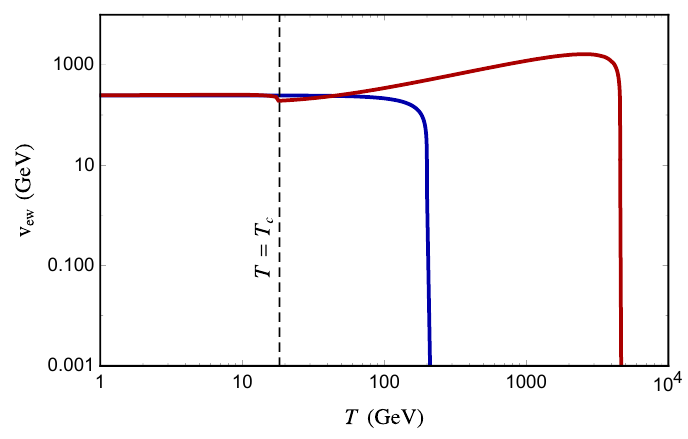
Figure 3 . Higgs Higgs expectation value, v ew , as a function of temperature for the parameters of equation (3.22) (blue) and equation (5.3) (red). The dashed line is the critical temperature, T c = 18 GeV for the choice of parameters in equation